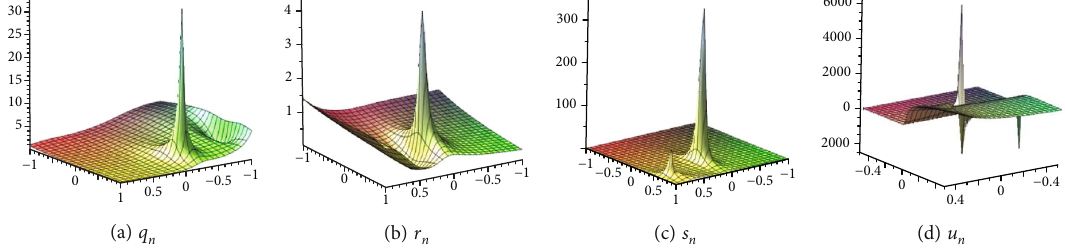
ffiffiffi p 3 I , and κ 2 =